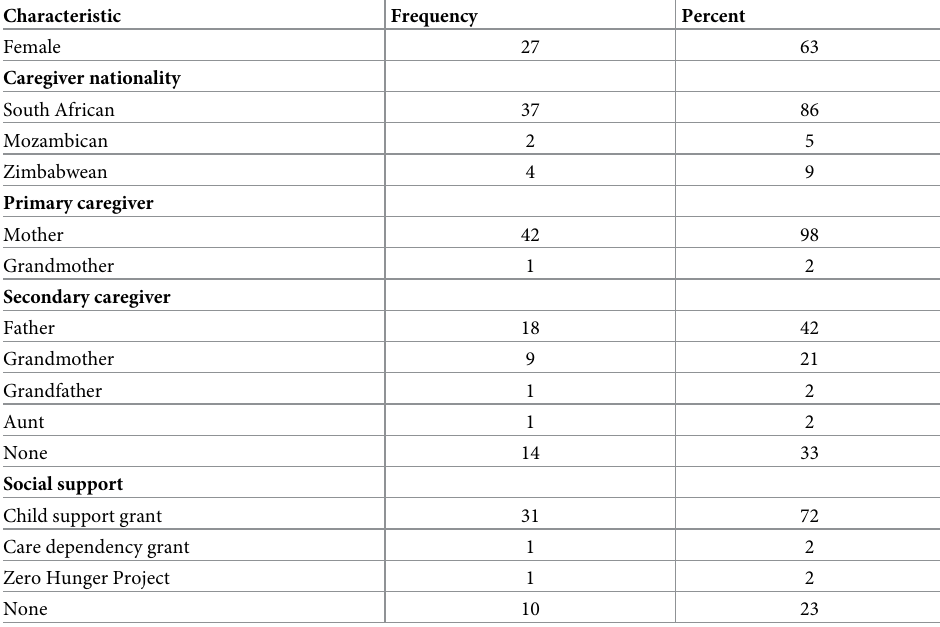
Table 1. Baseline characteristics of participants discharged from SAM in-patient treatment (n =